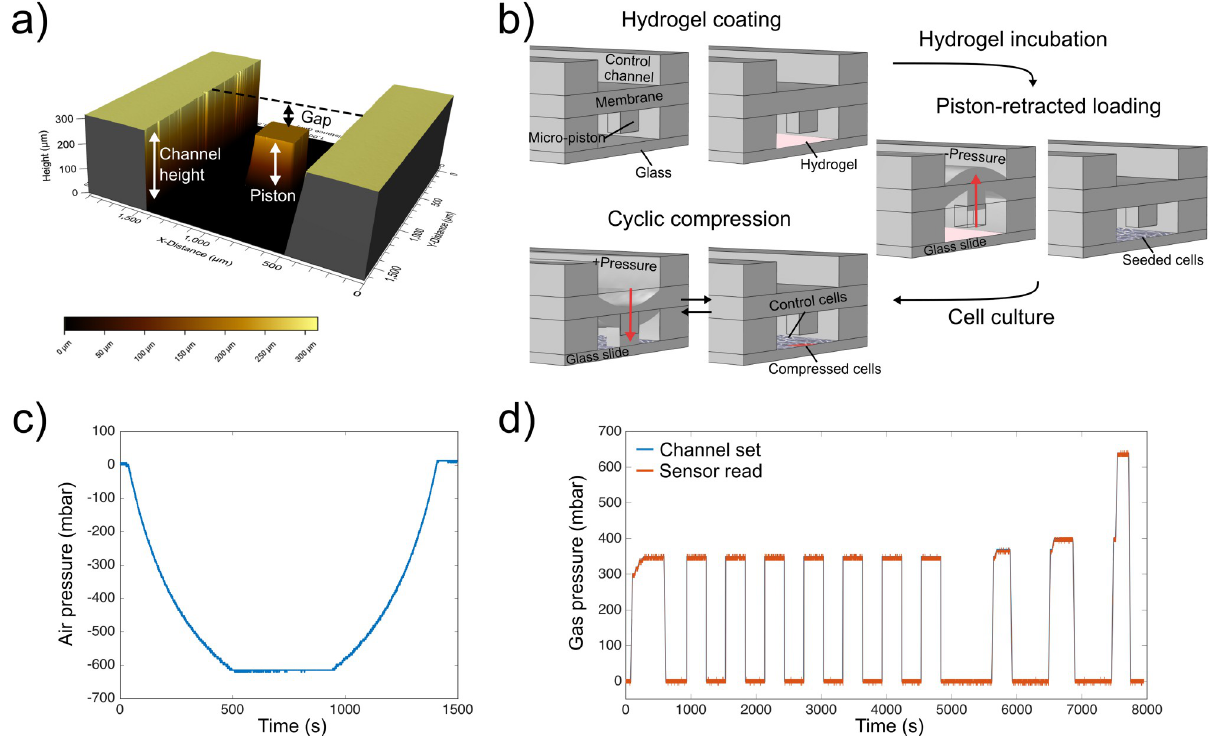
Fig 1. Device design, operation and applied pressure profiles. (a) 3D optical profilometer image of a micro-piston device showing the compartment including total height of the channel where the micro-piston is suspended, height of the micro-piston and the gap between the piston and surface of the channel. (b) Device operation steps from hydrogel coating, to piston-retracted loading of cells and cyclic compression on cells. The device was kept in static state during hydrogel loading and put into piston-retracted state for cell loading. In this state the membrane, and thus micro-piston, are retracted from the static position towards the top control channel by the applied negative pressure. After loading and settlement of the cells, flexible components were actuated down to their initial position. Cyclic compression of cells is illustrated by the membrane deflection and micro-piston brought onto cells by pressure applied through the control channel and retracted back after compression (repeated cyclically). Representative pressure profiles for piston- retracted loading, and sequential cyclic compression process are shown in (c) and (d), respectively.